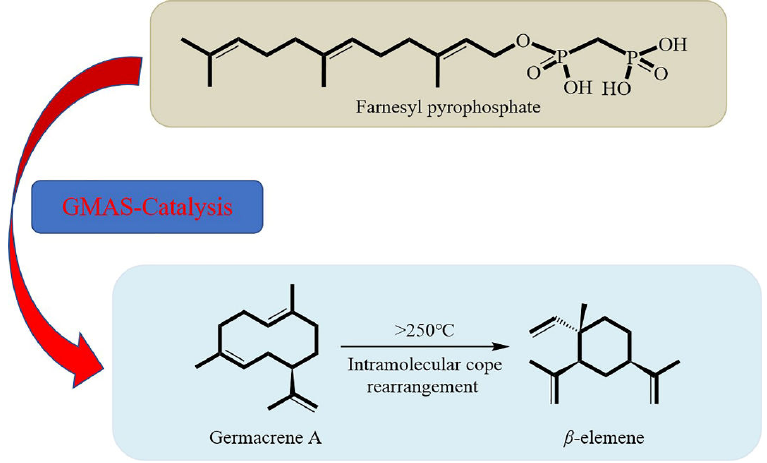
Figure 4. Synthetic steps of β -elemene. GMAS: Germacrene A is a synthase catalyst.